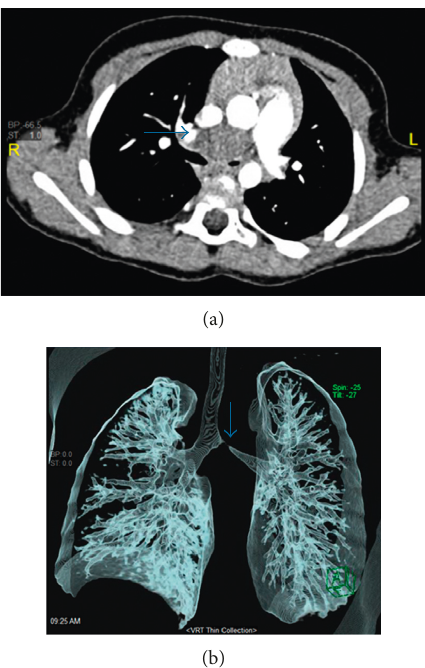
Figure 2: (a) CTscanofthechestshowing ahypodensecysticlesionin the middle mediastinum (arrow), causing compression on the carina and the proximal aspect of the mainstem bronchi, more pronounced on the left main bronchus. (b) 3D reconstruction of the CT scan showing a significant narrowing of the left main bronchus (arrow), caused by external compression of the adjacent cystic